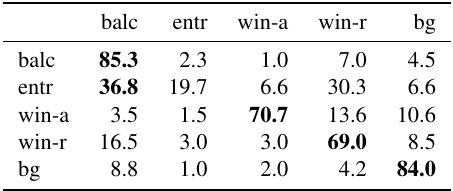
Table 2: Confusion matrix just using aggregates of A 3 , accuracy 75 . 2 , see Table 1